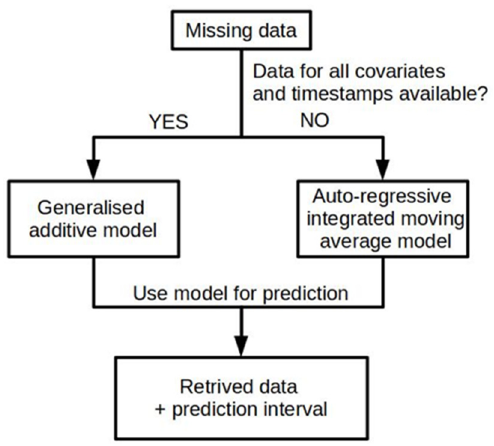
Figure 1. Reconstruction method. Flow chart of the method to predict the values of missing observations in high-frequency sensor data.